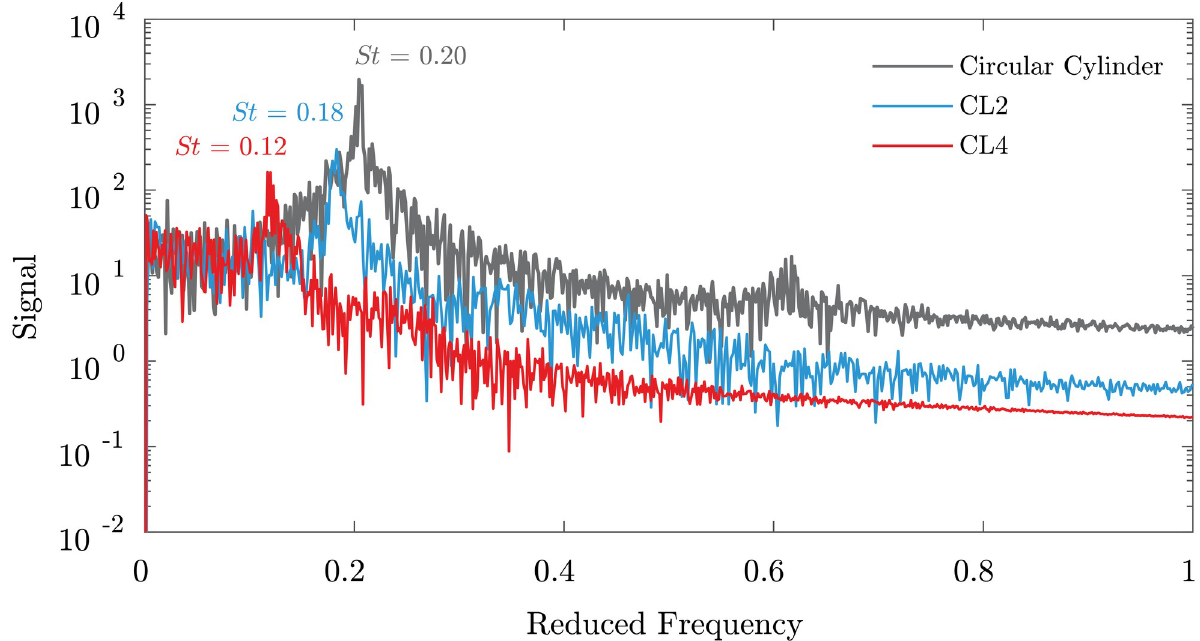
Fig 12. C L spectra for low and high A C geometries. The C L spectra for the CL2 (low A C ) and CL4 (high A C ) geometries shown in Fig 10 are directly compared with a smooth circular cylinder. A gradual decrease in St occurs as A